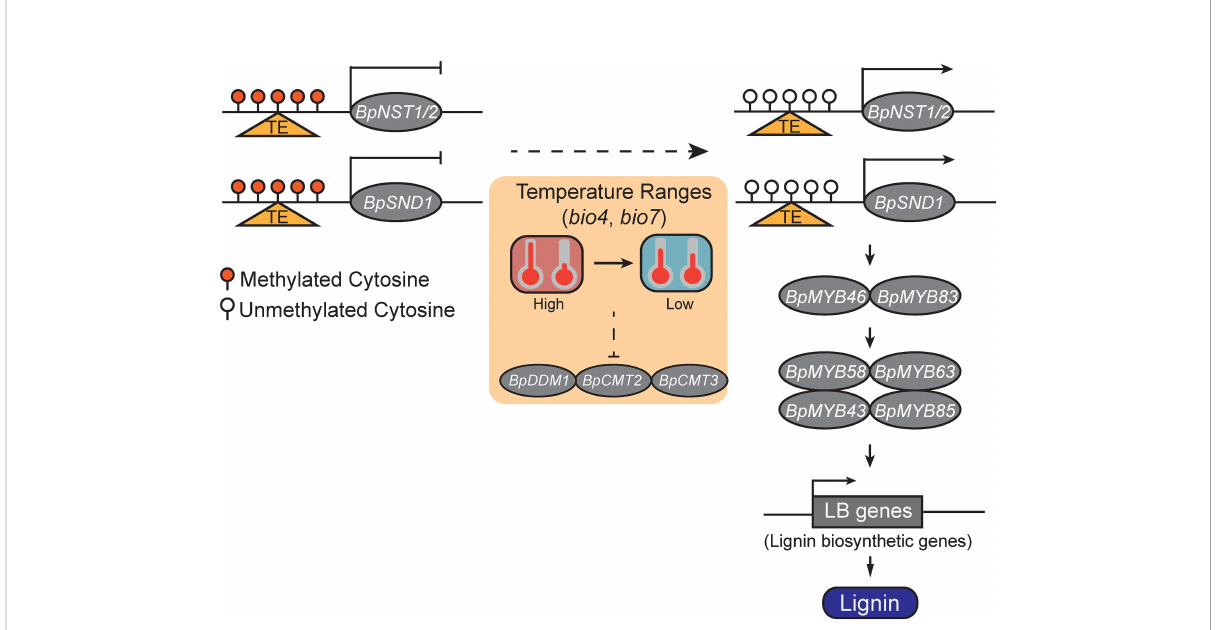
FIGURE 5 A schematic model of temperature ranges (TRs) responsive DNA methylation involved in lignin biosynthesis via the regulation of the expression of BpNST1/2 and BpSND1 . The small red balloons represent highly methylated cytosines, white ones represent unmethylated cytosines, and the triangles in orange indicate a genomic region with transposable element (TE) insertion. With a decreasing of TRs, the methylation levels of the promoter region of the BpNST1/2 and BpSND1 decrease and their expressions are thus enhanced, leading to the up-regulation of downstream MYB-domain TFs and lignin biosynthesis genes and, ultimately, increasing the content of lignin in